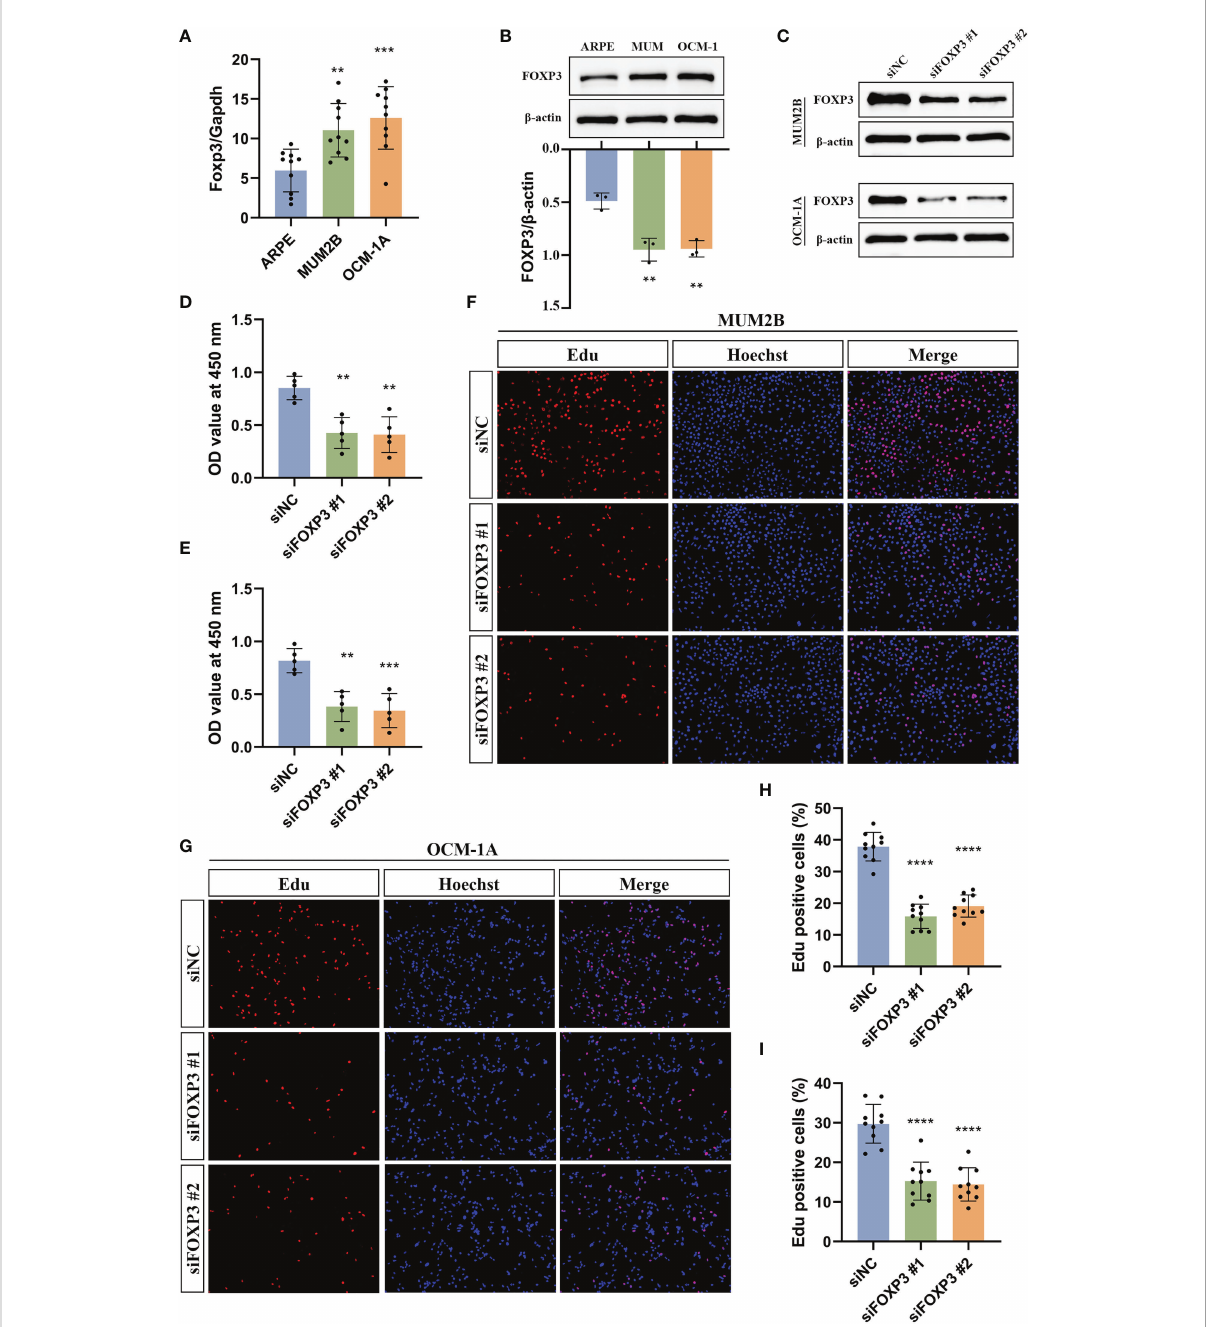
FIGURE 13 Experimental validation of the effect of FOXP3 on uveal melanoma growth. (A) The mRNA levels of Foxp3 in ARPE-19, MUM2B, and OCM-1A cells. (B) The protein levels of FOXP3 in ARPE-19, MUM2B, and OCM-1A cells. (C) Immunoblotting shows the knockdown ef fi ciency of siRNA in MUM2B and OCM-1A cells. (D, E) CCK-8 assays were used to measure the viability of MUM2B (D) and OCM-1A (E) cells after the knockdown of FOXP3. (F, G) The assessment of cell proliferation by using the EdU-DNA synthesis assays following the knockdown of FOXP3. (H) The percentage of Edu- positive cells in (F) was displayed. (I) The percentage of Edu positive cells in (G) was displayed. **P< 0.01, ***P < 0.001, ****P <